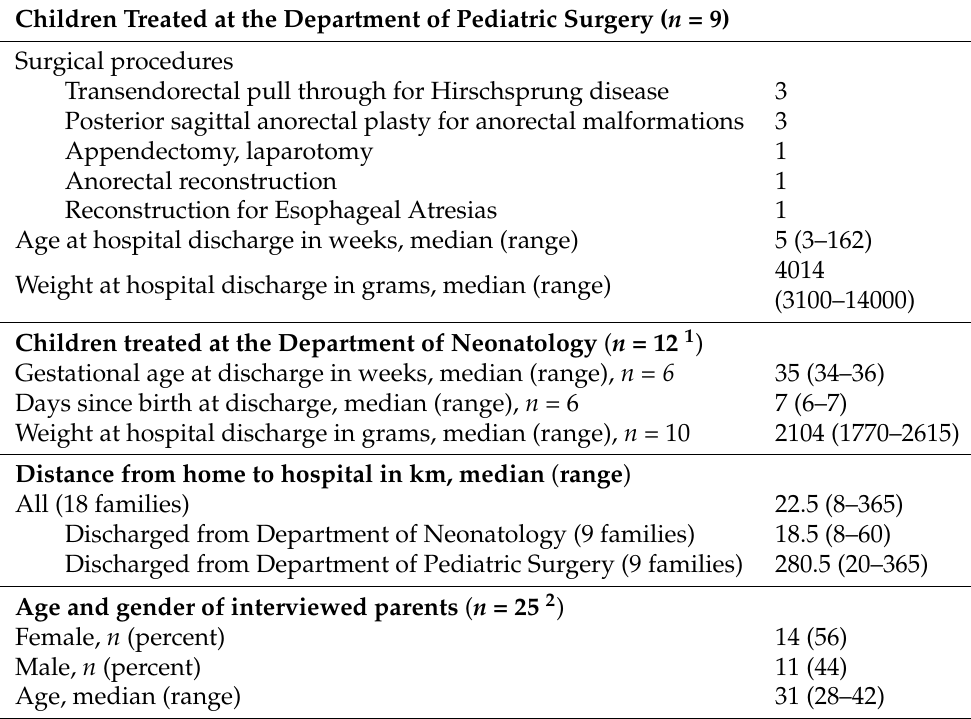
Table 1. Background characteristics of 21 children and 25 parents from 18 families that received eHealth devices and where at least one parent was